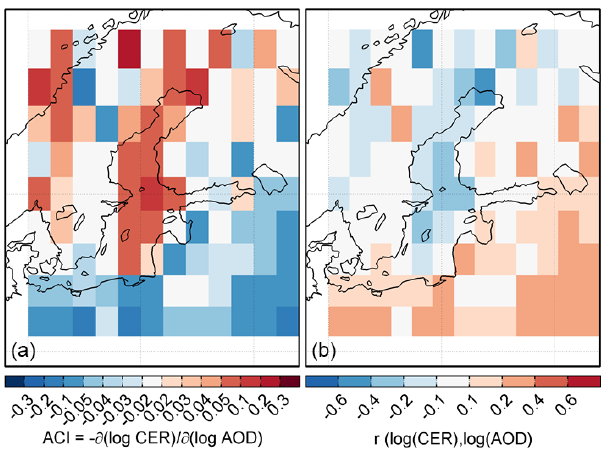
Figure 9. Applying the AOD as a proxy for the CCN, estimates of the ACI and correlation coefficient for the CER and for the interval of the LWP between 20 and 60gm − 2 were calculated on a grid basis. The obtained spatial distribution of the ACI is shown on the left and the correlation coefficient is shown on the